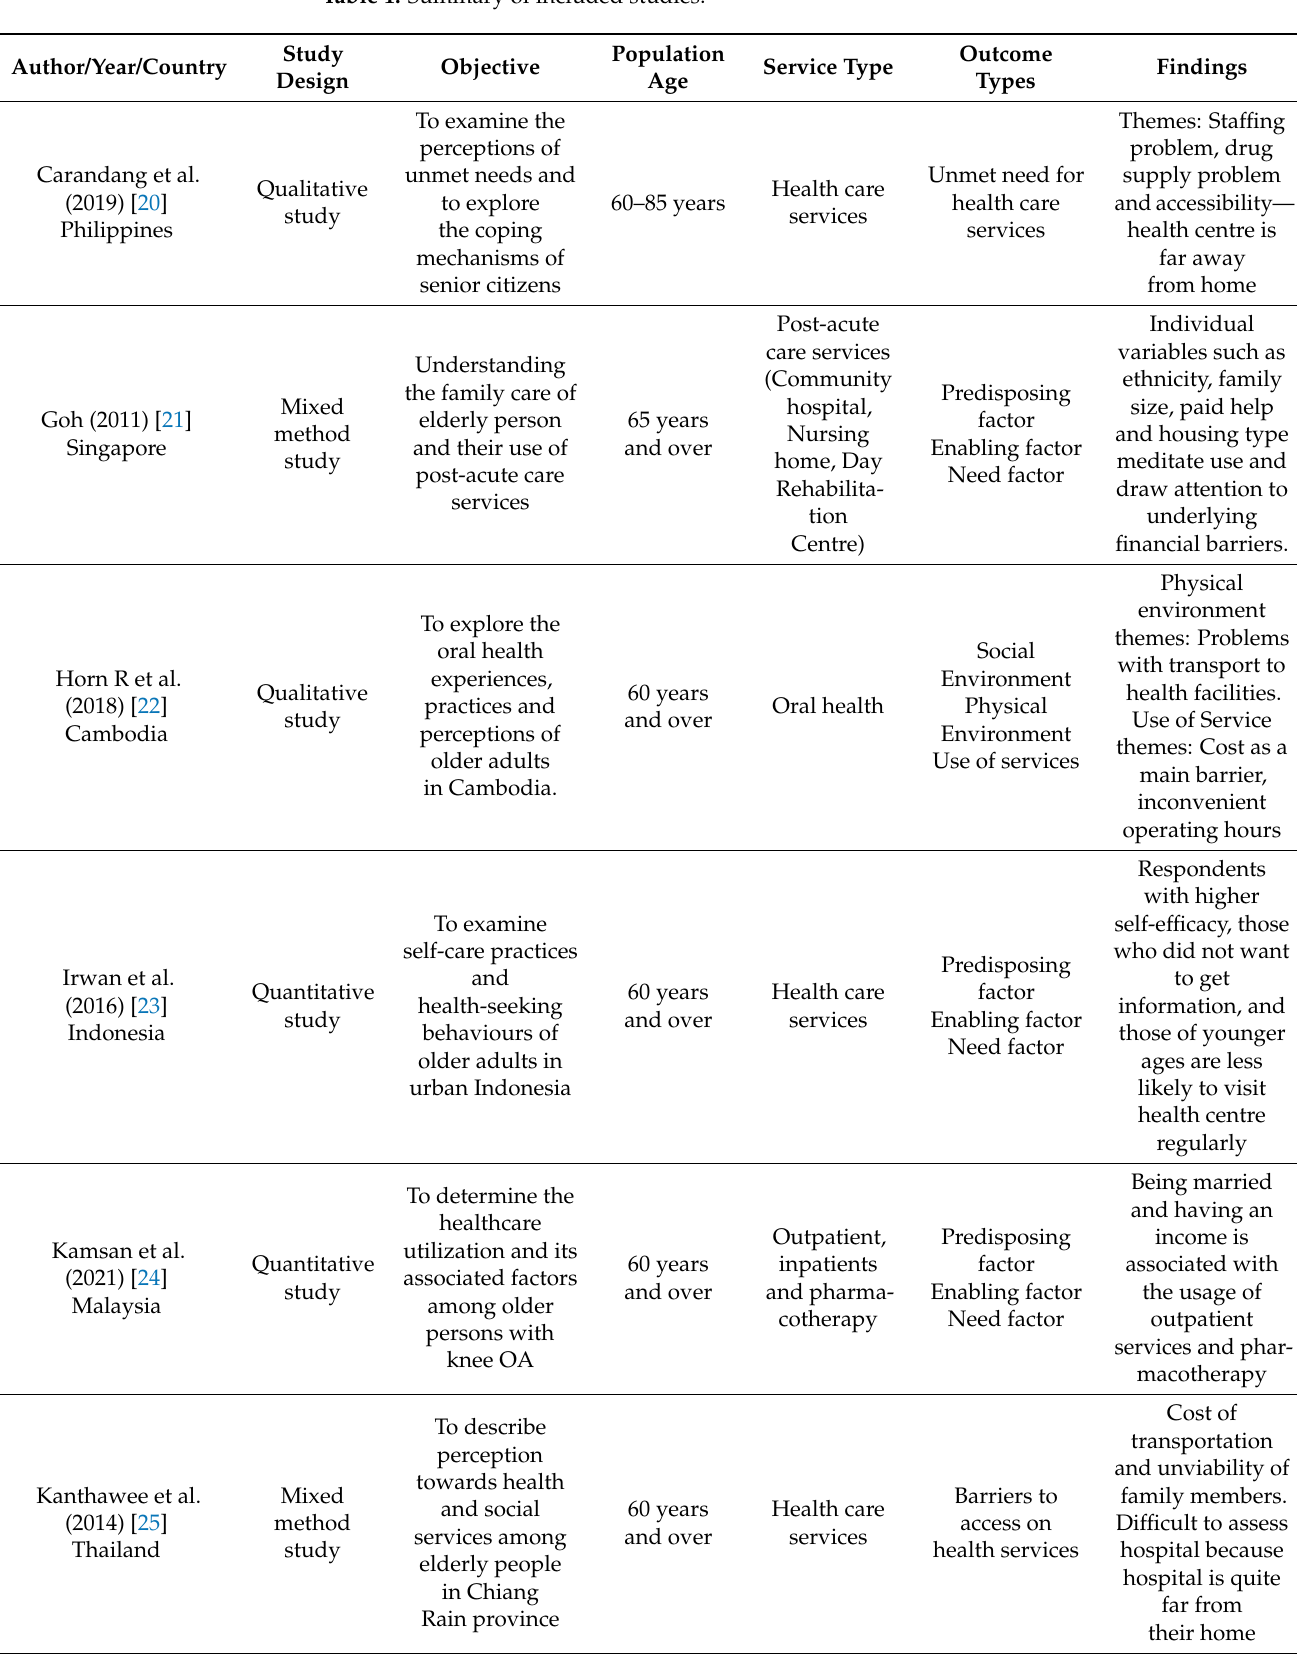
Table 1. Summary of included